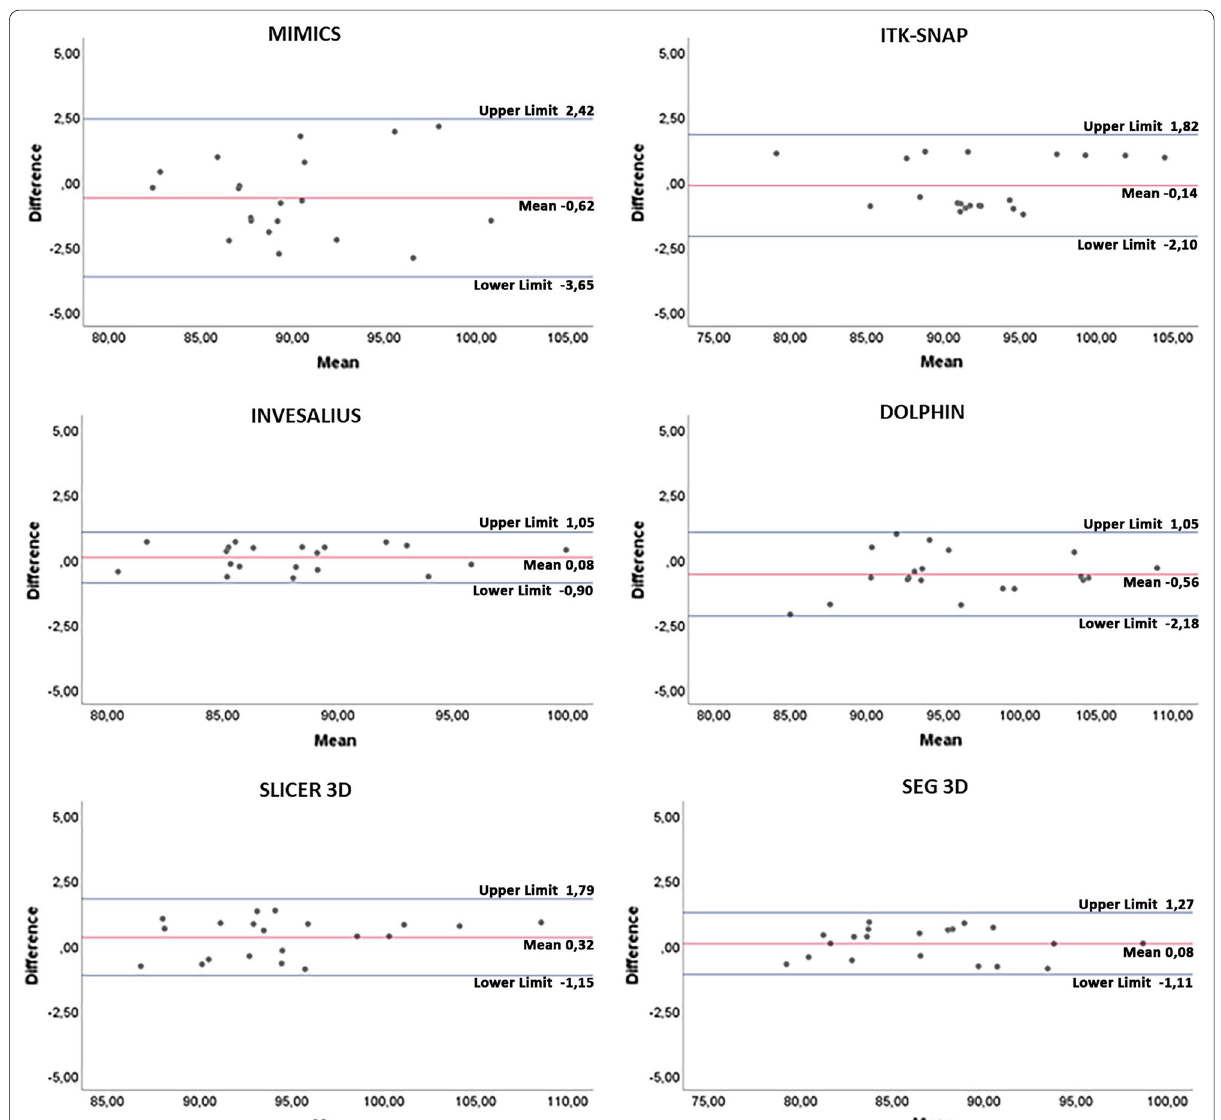
Fig. 7 Bland–Altman plot with lines of agreement between first and second intra-operator readings of semi-automatic segmentation of the upper